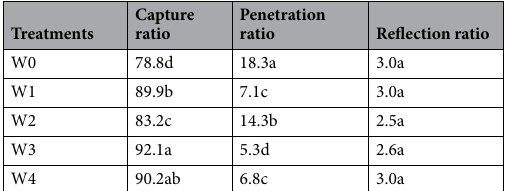
Table 2. Photosynthetically active radiation (PAR) capture ratio, penetration ratio, and reflection ratio in winter wheat canopy of each treatment (%) The data were the average values on May 1, May 16, and June 1 in 2013. W0: rainfed, W1: a local supplemental irrigation practice at jointing and anthesis with 60 mm each time, W2, W3 and W4 are supplemental irrigation determined by measuring 0–20 cm, 0–40 cm, and 0–60 cm soil layer moisture, respectively, and brought the soil moisture to 65% FC at jointing and 70% FC at anthesis. Within a column values followed by different letters differ significantly at the 0.05 level by the LSD